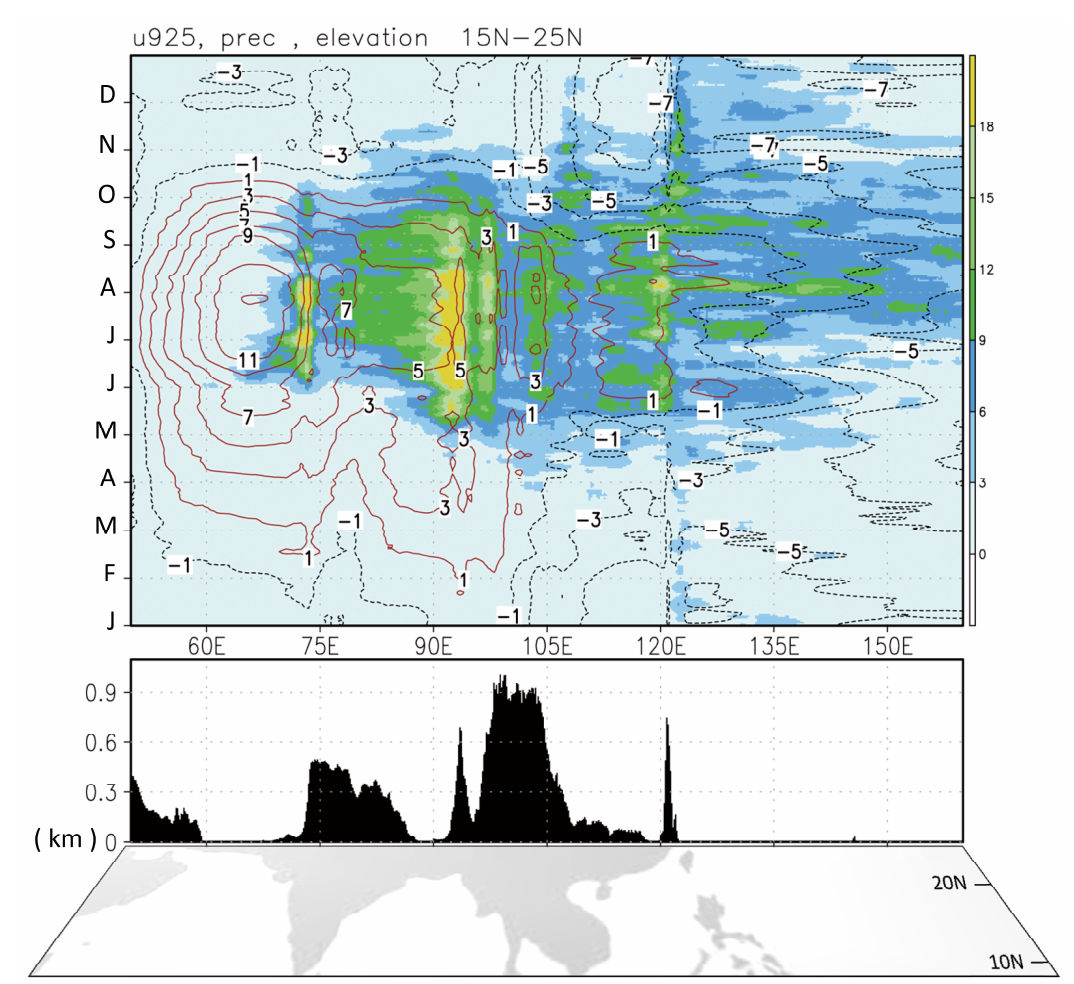
Figure 6. Longitude–time cross sections of precipitation (mm day −1 ; shadings) and 925–hPa zonal Figure 6. Longitude-time cross sections of precipitation (mm day − 1 ; shadings) and 925-hPa zonal winds (m s −1 ; contour lines) in 15° N–25° N. Black bars in the bottom panel denote the averaged winds (m s − 1 ; contour lines) in 15 ◦ N–25 ◦ N. Black bars in the bottom panel denote the averaged elevation (km) in the region. elevation (km) in the